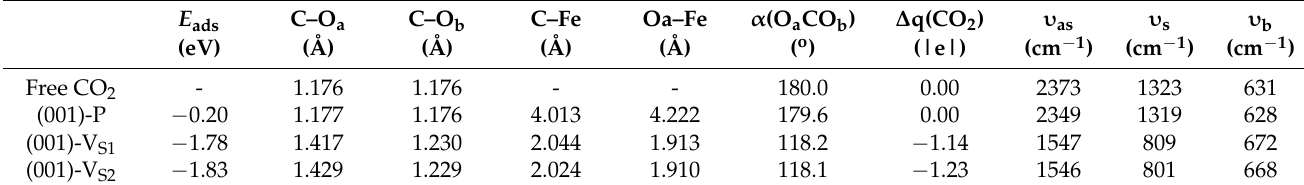
Figure 3. Lowest-energy adsorption structures of CO 2 on the perfect ( a ) and defective ( b , c ) FeS (001) surfaces with V S1 and V S2 . The inserts show the top views. (atomic colour: Fe = grey, S = yellow, C = green, O = red). The CO 2 molecule on the other hand, chemisorbs strongly at the defective surfaces, binding to the exposed Fe sites (Figure 3b,c). The adsorption energy for CO 2 at the defec- tive V S1 and V S2 surfaces is calculated at − 1.78 and − 1.83 eV, respectively. The CO 2 molecule gained a significant amount of charge from the interacting surface Fe ions, resulting in the